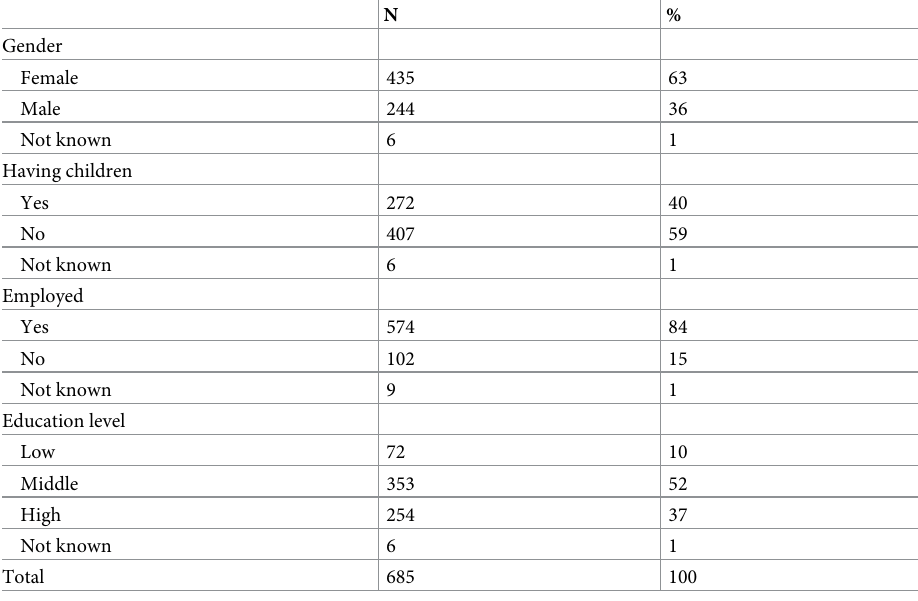
Table 1. Reported demographic information in Study